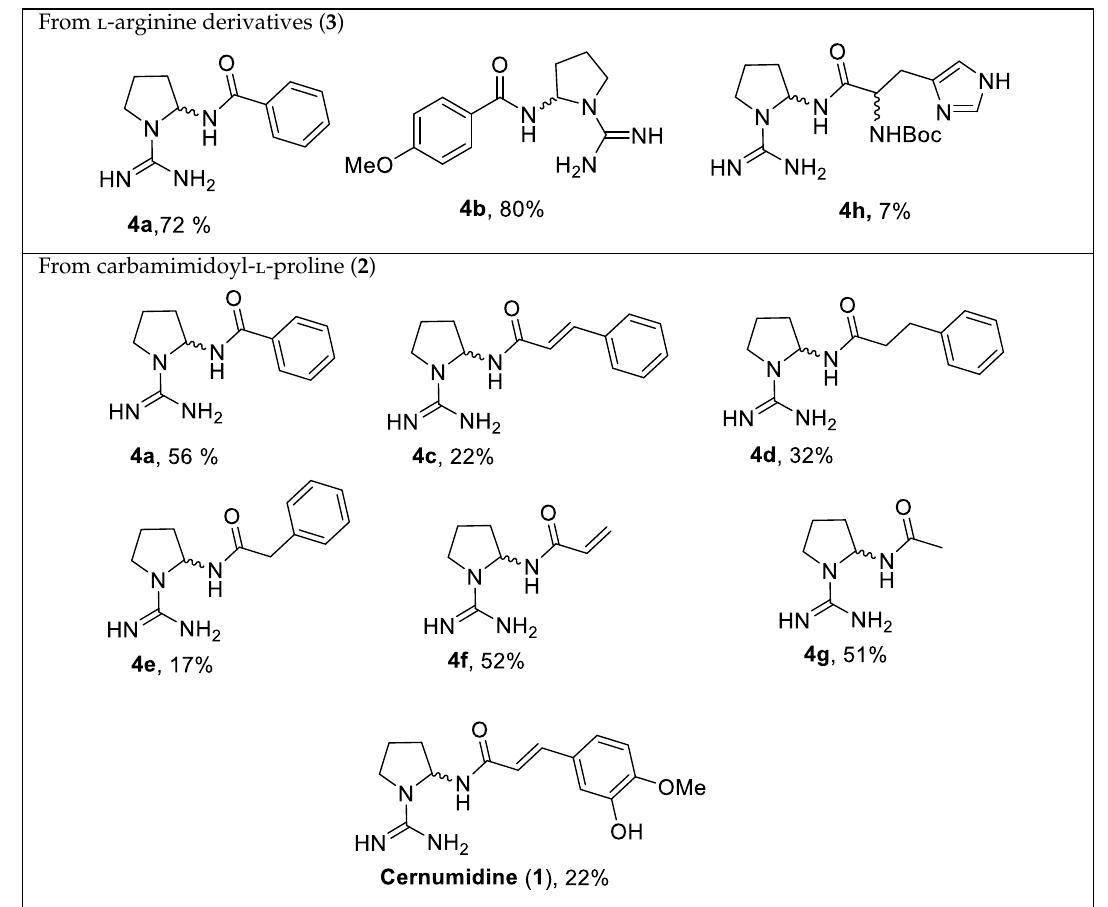
Table 3. Scope of substrates for the oxidative decarboxylation of L -arginine derivatives ( 3 ) and carbamimidoyl- L -proline ( 2 ).